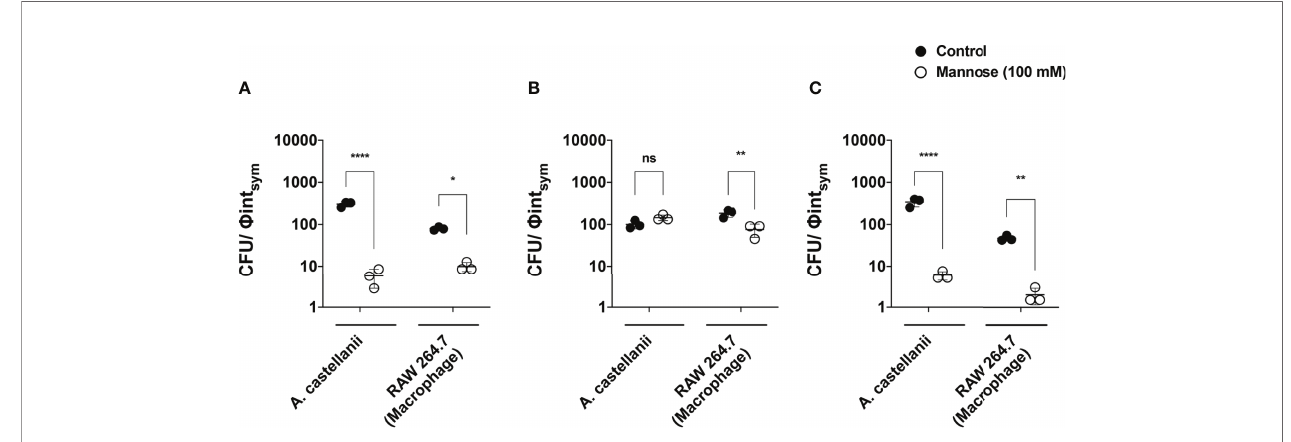
FIGURE 10 | The mannose receptor plays an important role in fungal survival inside Acanthamoeba castellanii and RAW macrophages. The phagocyte interaction assays with (A) Candida albicans , (B) Cryptococcus neoformans and (C) Histoplasma capsulatum were performed in the absence (solid circles) and presence of 100mM soluble mannose (empty circles), and fungal viability was assessed by determining the number of Colony Forming Units (CFUs) 24 h upon interaction to assess the fungicidal capacity of phagocytes (*p < 0.05, **p < 0.01 or ****p < 0.0001 indicate statistically signi fi cant decrease upon mannose inhibition; ns, not signi fi cant). The data represent the average of three independent experiments, performed in